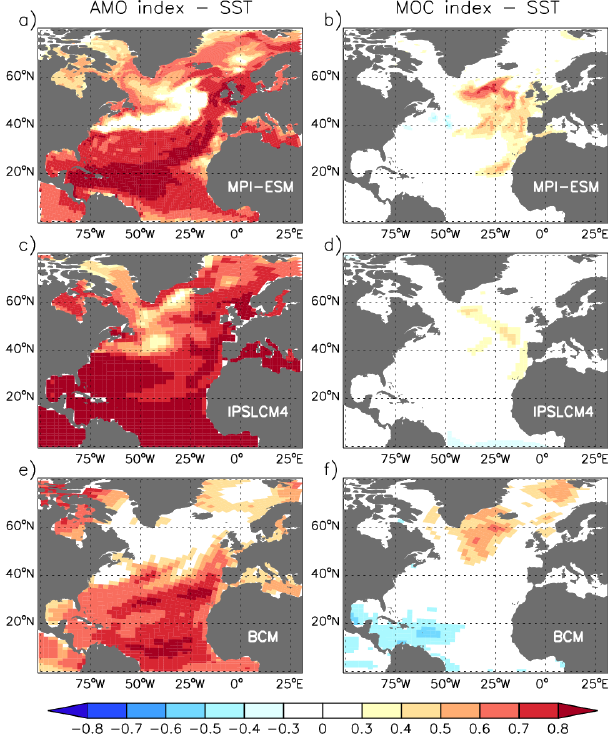
Figure 4. Left panels: zero-lag correlation coefficients between the AMO index and the North Atlantic SST in MPI-ESM (a) , IPSLCM4 (c) and BCM (e) . Right panels: correlation coefficients between the maximum strength of the North Atlantic MOC and the North At- lantic SST in MPI-ESM (b) , IPSLCM4 (d) and BCM (f) . The MOC index is leading by 5 years. The correlation analysis is based on an- nual values for the period AD850 to 1849 (MPI-ESM, IPSLCM4) and AD1550 to 1999 (BCM) with a 21-year running mean filter ap- plied. For IPSLCM4, the data have been linearly detrended prior to the analysis to account for the model drift. Only correlation coeffi- cients statistically significant at the 95% confidence level are shown (significance level: 0.27 in MPI-ESM and IPSLCM4, 0.4 in